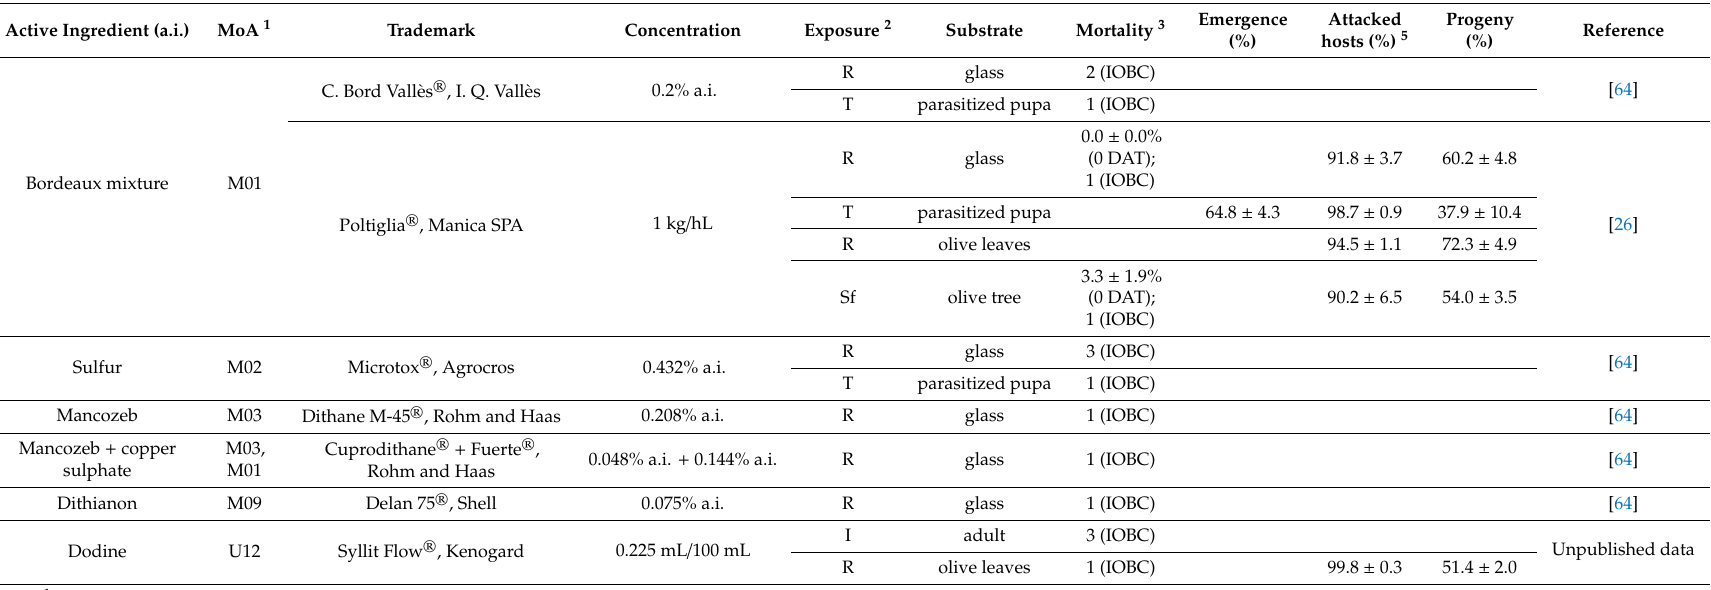
Active Ingredient